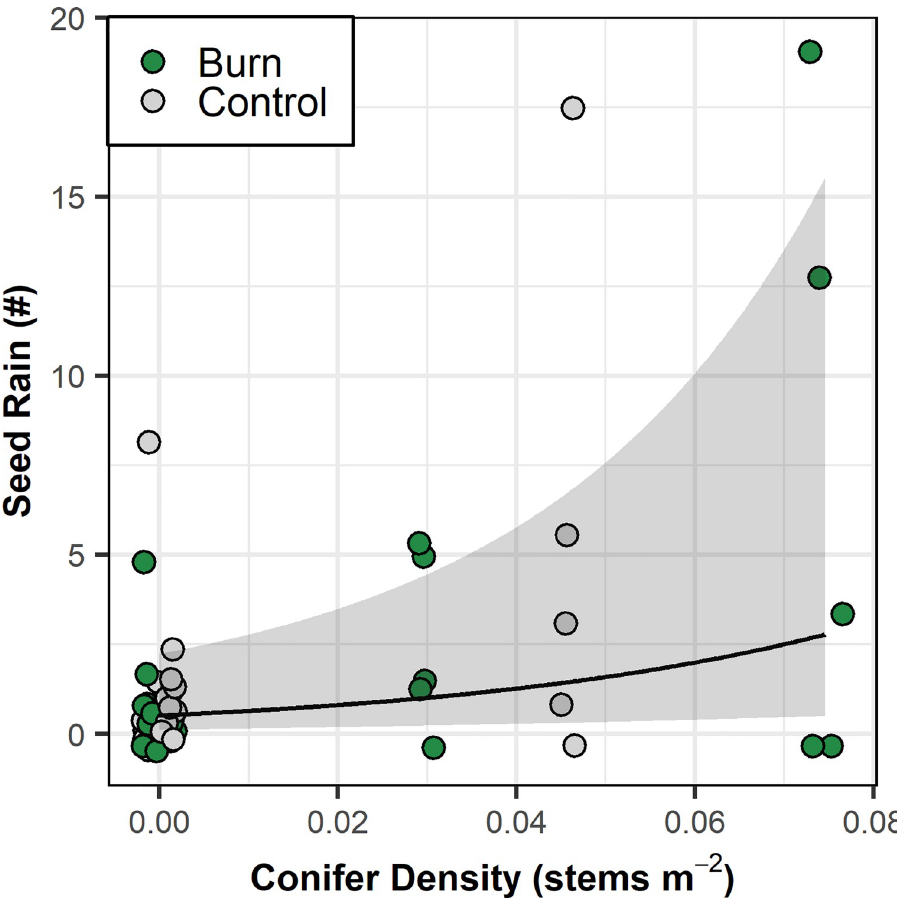
Fig 9. Seed rain (#) as a function of conifer density (stem � m -2 ). Black line represents modelled relationship from a generalized linear mixed effect model with a type II negative binomial distribution and random effects of collection period (5 levels) crossed with grid (2 levels). Shading represents 95% confidence region. See Table 2 for model results.